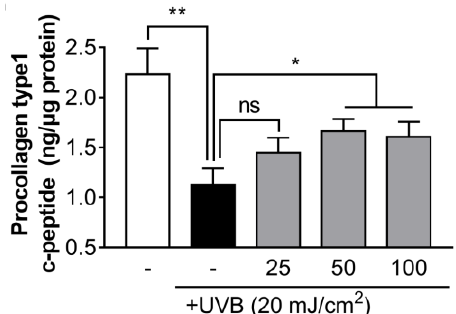
Figure 2. The effect of decanal on UVB-induced collagen degradation in Hs68 dermal fibroblasts. The collagen content was measured in the supernatant of Hs68 cells treated with either the vehicle or 25, 50 and 100 μM decanal for 24 h after UVB exposure. The final procollagen type I level was normalized to the total cellular protein content. Data are shown as the mean ± SEM ( n = 3). Significant differences are indicated as * p < 0.05; ** p < 0.01.